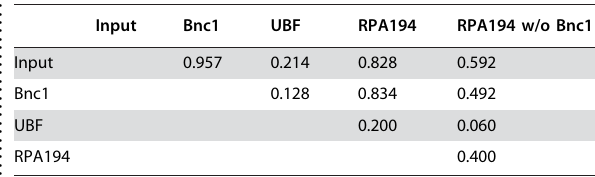
Table 1. P values of pair-wise comparison of SNP frequency in